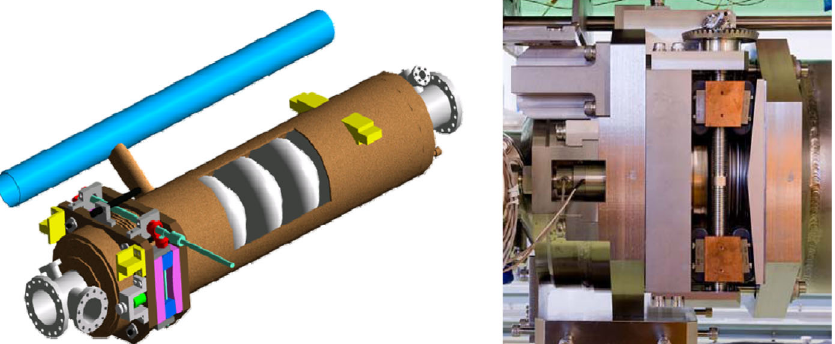
FIG. 5. (Color) Slide-jack tuner system for adjusting resonant frequency. A schematic drawing of the entire cavity system (left) and the completed assembly of the frequency tuner system with a pair of slide jacks and a piezo element